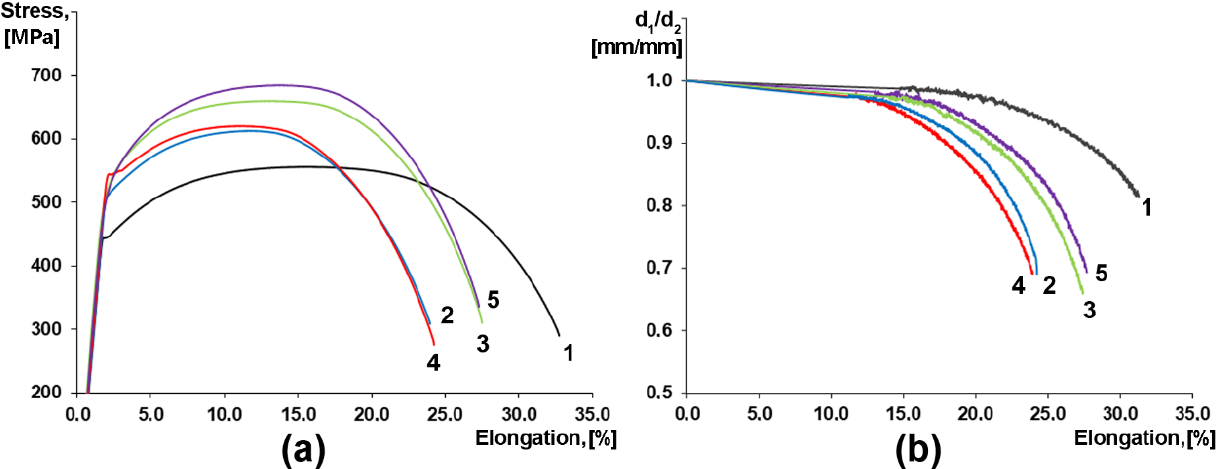
Figure 6. Taylor factors in TD for the central areas of the pipeline steel plates after TMCP.